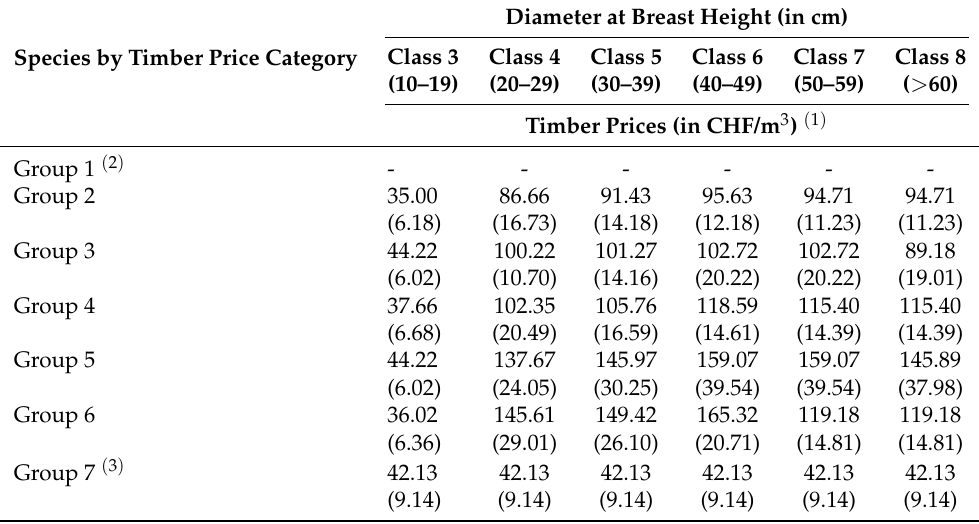
Table 2. Timber prices year 2014 by group of species and size class.